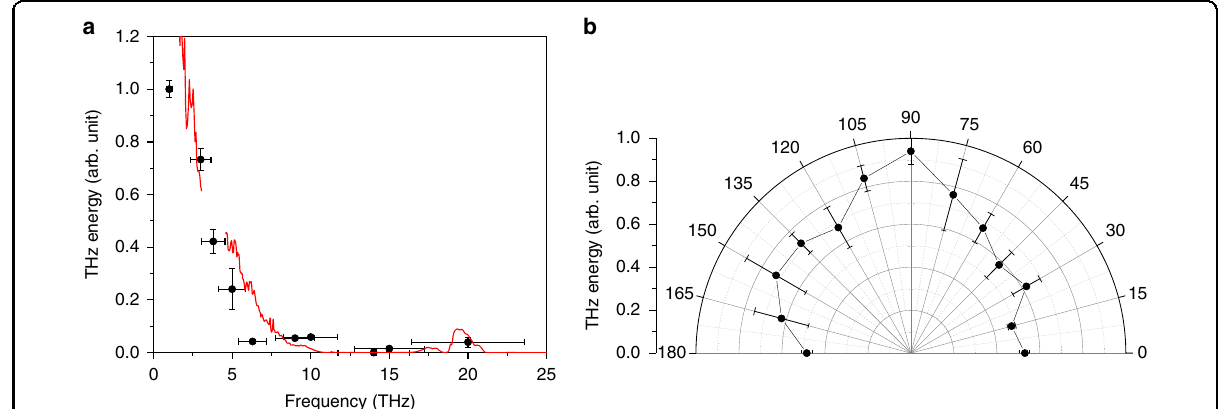
Fig. 4 THz spectrum and polarization. a Discrete THz spectrum characterized with bandpass fi lters for the pure nitrogen gas target. The horizontal error bars represent the spectral width (FWHM) of the fi lter ’ s transmission band. The red line represents an overall transmission curve of all fi lters placed in the beam path. b THz polarization characterized with a wire grid polarizer. The laser is linearly polarized along the horizontal axis (0 or